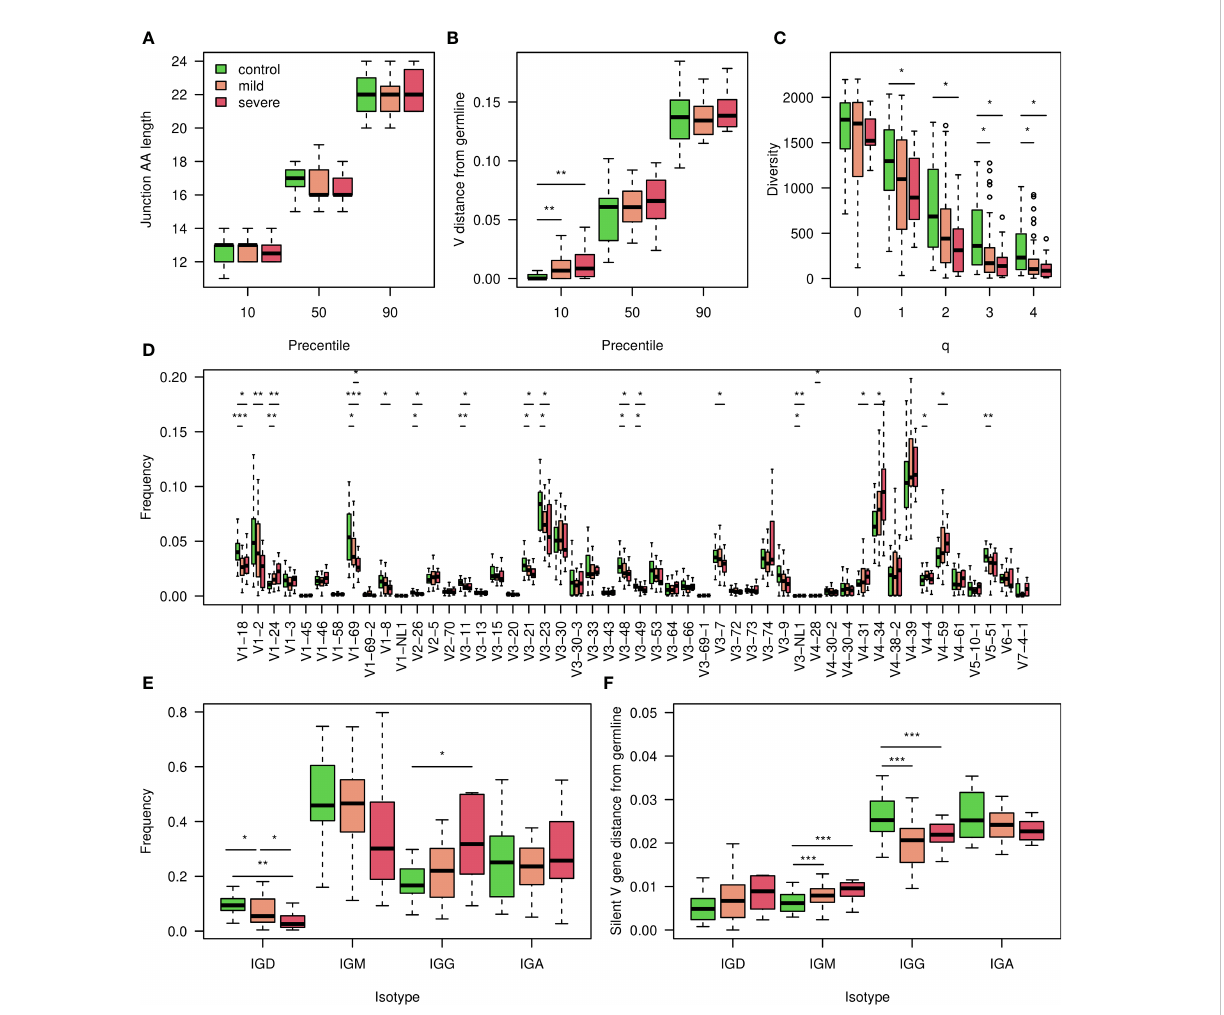
FIGURE 1 Characterization of the COVID-19 heavy chain BCR cohort. (A) 10,50 and 90 percentiles of AA CDR3 length in individuals with corona at indicated severity and controls. (B) 10,50 and 90 percentiles of V gene distances from germline in COVID-19 infected individuals at indicated severity and controls. (C) Boxplot showing calculated Hill diversity indexes upon different q values between individuals infected by COVID-19 at indicated severity and controls. (D) Boxplots showing V gene usage in individuals infected by COVID-19 at indicated severity and controls, shown top 50 ’ s mean frequencies. (E) Boxplots showing the isotype frequencies in individuals infected by COVID-19 at indicated severity and controls. (F) Boxplots showing silent mutations ’ frequencies along the V gene in different isotypes of individuals infected by COVID-19 at indicated severity and controls. In the whole fi gure, * marks P value less than 0.05. ** marks P value less than 0.01 and *** marks P value less than